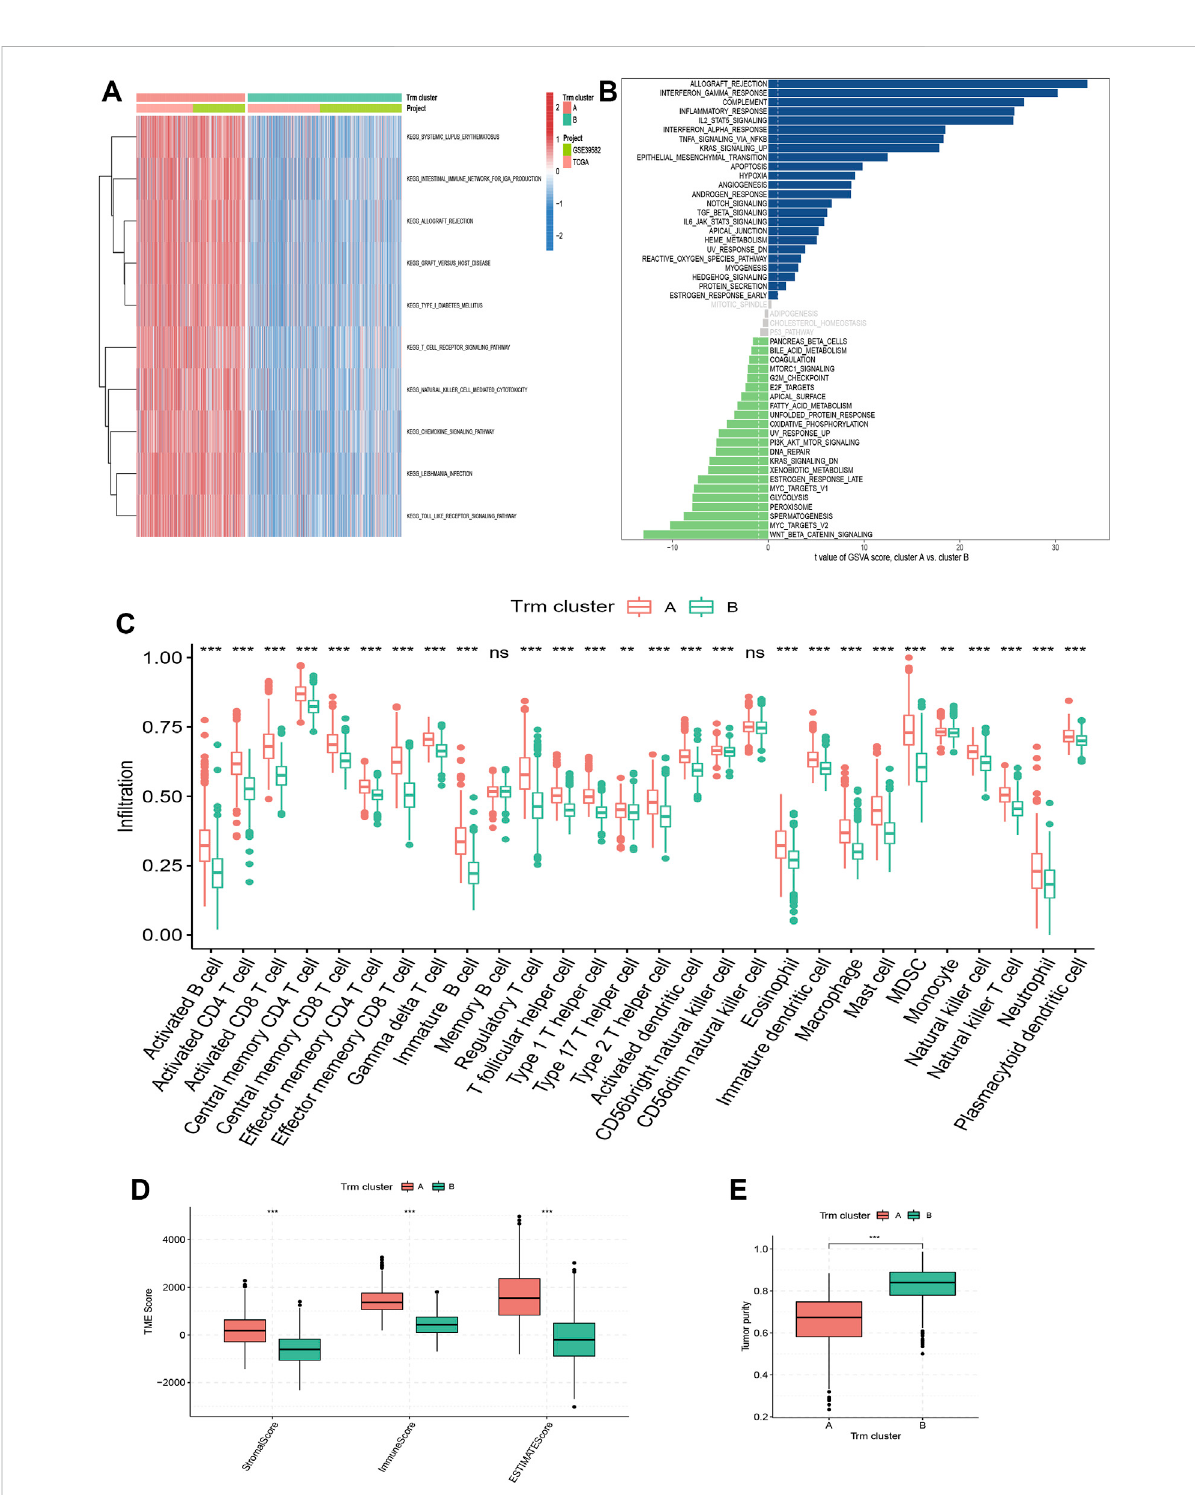
FIGURE 3 Correlation of Trm clusters with biological function and TME landscapes. (A) Heatmap showing the enrichment pattern of KEGG items for two Trmclusters. (B) Bar plotshowingtheenrichmentpattern ofHallmarkitems for twoTrmclusters. (C) Boxplots comparing thein fi ltration differences of 28 immune cells between two Trm clusters. (D,E) Box plots comparing the differences in (D) TME score and (E) tumor purity between two Trm clusters. TME: Tumor microenvironment; KEGG: Kyoto Encyclopedia of Genes and Genomes. Statistical Signi fi cance: ** p < 0.01; *** p < 0.001; ns, not signi fi